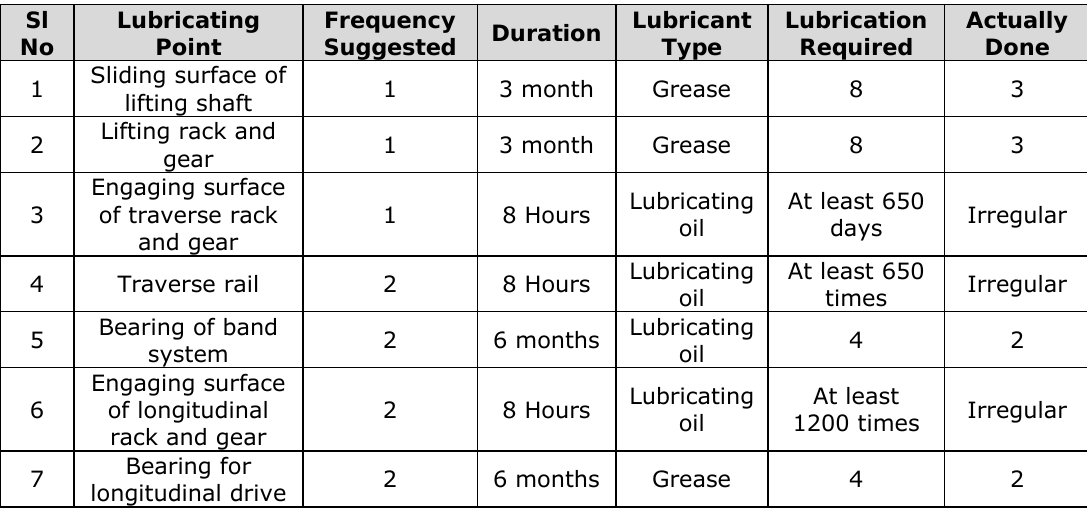
Table 6. “Lubrication points, their frequency and